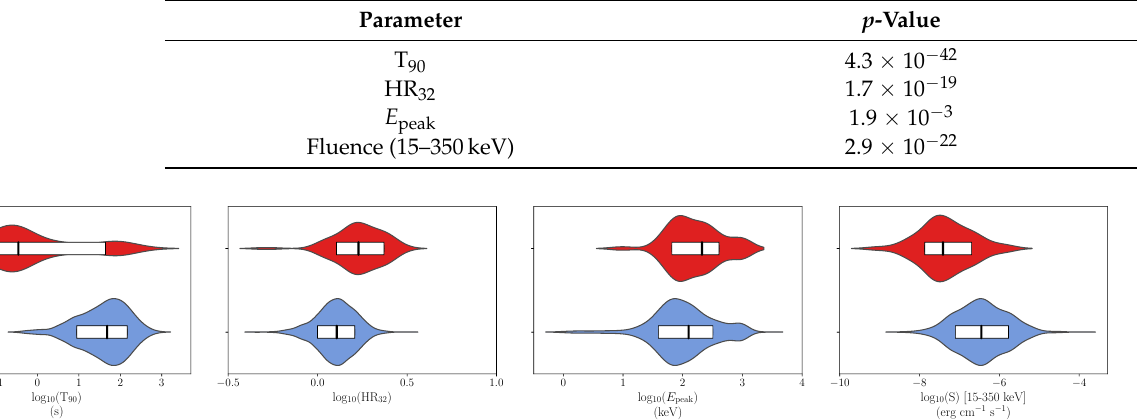
Figure 7. Violin plots showing the distribution of GRB properties for Group 1 (red) and Group 2 (blue) Swift /BAT bursts identified in the T 0 to T 0 + 1.004s light curve interval. The white box plots represent the 1 σ interval (i.e., the 16th to 84th percentile), with the median of each parameter marked as a black